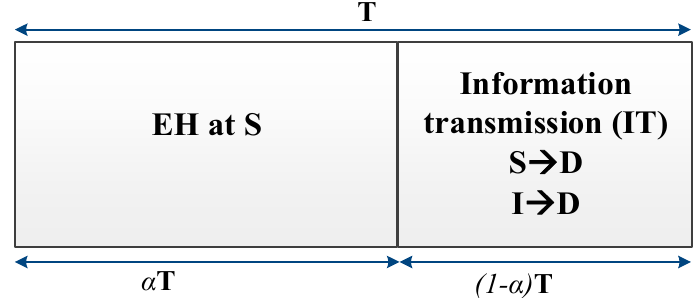
Figure 2. EH and information processing. T, the whole transmission block.